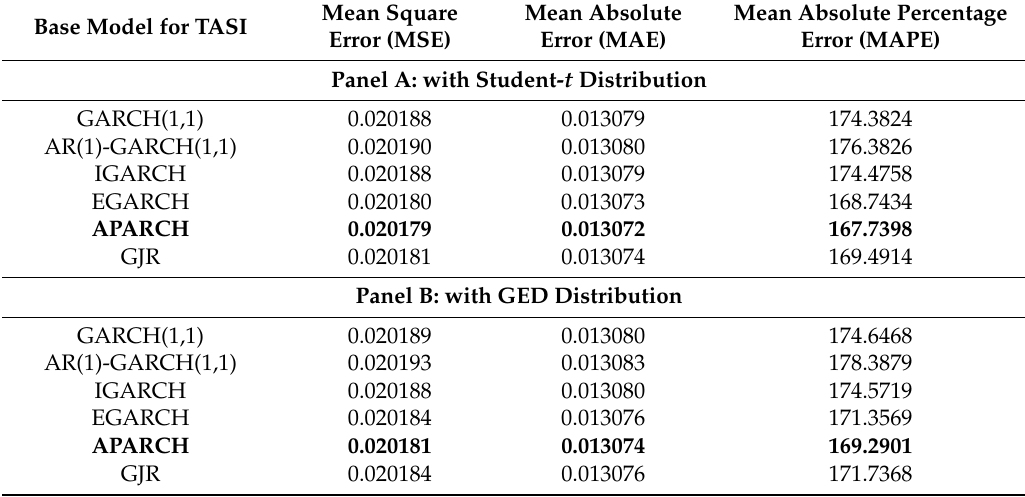
Table 4. Evaluation of one-day out-of-sample volatility forecasts comparison for TASI. The table presents the loss functions values of TASI. Panel A displays the loss functions values for one-day out-of-sample volatility forecasts of TASI using Student- t distribution. Panel B displays the loss functions’ values for one-day out-of-sample volatility forecasts of TASI using GED distribution. This table also presents the forecasting criteria: Mean Square Error (MSE), Mean Absolute Error (MAE), and Mean Absolute Percentage Error (MAPE). Lowest values for the statistics are denoted in bold face. GARCH: generalized autoregressive conditional heteroskedasticity, AR-GARCH: